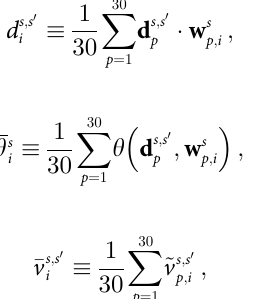
as a function of Δ t between the earlier session s and later session s 0 , see Sec. 4.1 above for defini- tions of the quantities on the right-hand side of these expressions. Note the distinction of s and s 0 matter for these quantities. Finally, for Fig 2h the chance percentage for drift randomly ori- ented in neural state space was computed analytically. For a randomly oriented drift vector projected onto a d D s e dimensional subspace, g s ; s 0 ¼ d D s e = n . This quantity was averaged over p p p stimulus groups and the three distinct drifts, before the average and standard error was com- puted across mice. Fig 3 details. The scatter plots in Fig 3a, 3b and 3c are averaged over p and plotted for each mouse and all three session-to-session drifts, i.e. 1 ! 2, 2 ! 3, and 1 ! 3, as a function of the corresponding v . Any plot data with v � 10 − 5 was omitted. For Fig 3a, 3b and 3c, they i i are respectively